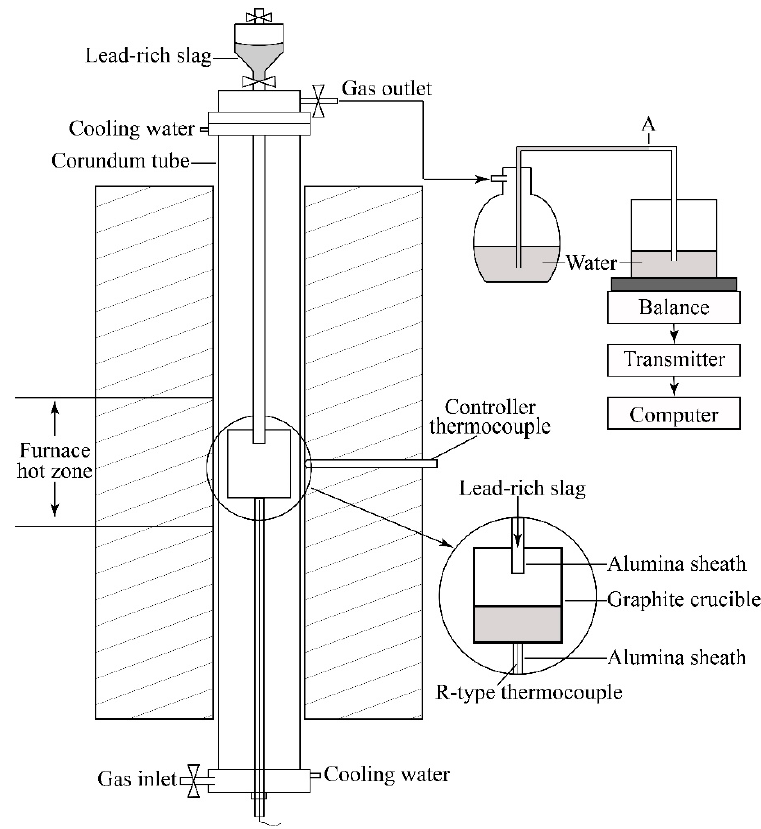
Figure 1. Schematic diagram of the experimental system used in this study. The graphite crucible was raised from the bottom to the hot zone of the reaction tube after 30 min flushing by ultrahigh purity argon. The gas flushing was stopped, and the reaction tube was sealed properly. The argon gas was then turned on carefully to enable the water to stay at point A indicated in Figure 1 and then the argon gas was stopped. The balance was adjusted to zero and the computer was started to record the weight changes. A 5.00 g lead-rich slag (~1 mm diameter size) was added into the graphite crucible from when the sample touched the graphite crucible at the required temperature. The generated CO/CO 2 gases were captured by the water-containing pressure device and the weight of water was continuously recorded by the computer in 5 s interval. When the experiment finished, up to 400 mL CO/CO 2 gases were generated and displaced approximately 400 g H 2 O into a container sitting on a balance. The reduction was stopped when the graphite crucible was lowered rapidly to the bottom-end of the